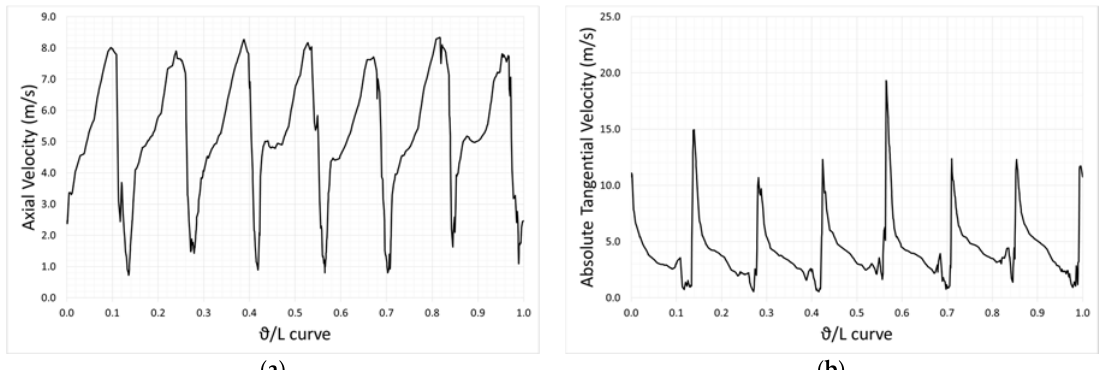
Figure 6. In this Figure, the velocity components of the absolute velocity at the outlet of the runner are represented: ( a ) Axial velocity along the mean radius at the trailing edge of the blade at the BEP; ( b ) Tangential velocity along the mean radius at the trailing edge of the blade at the